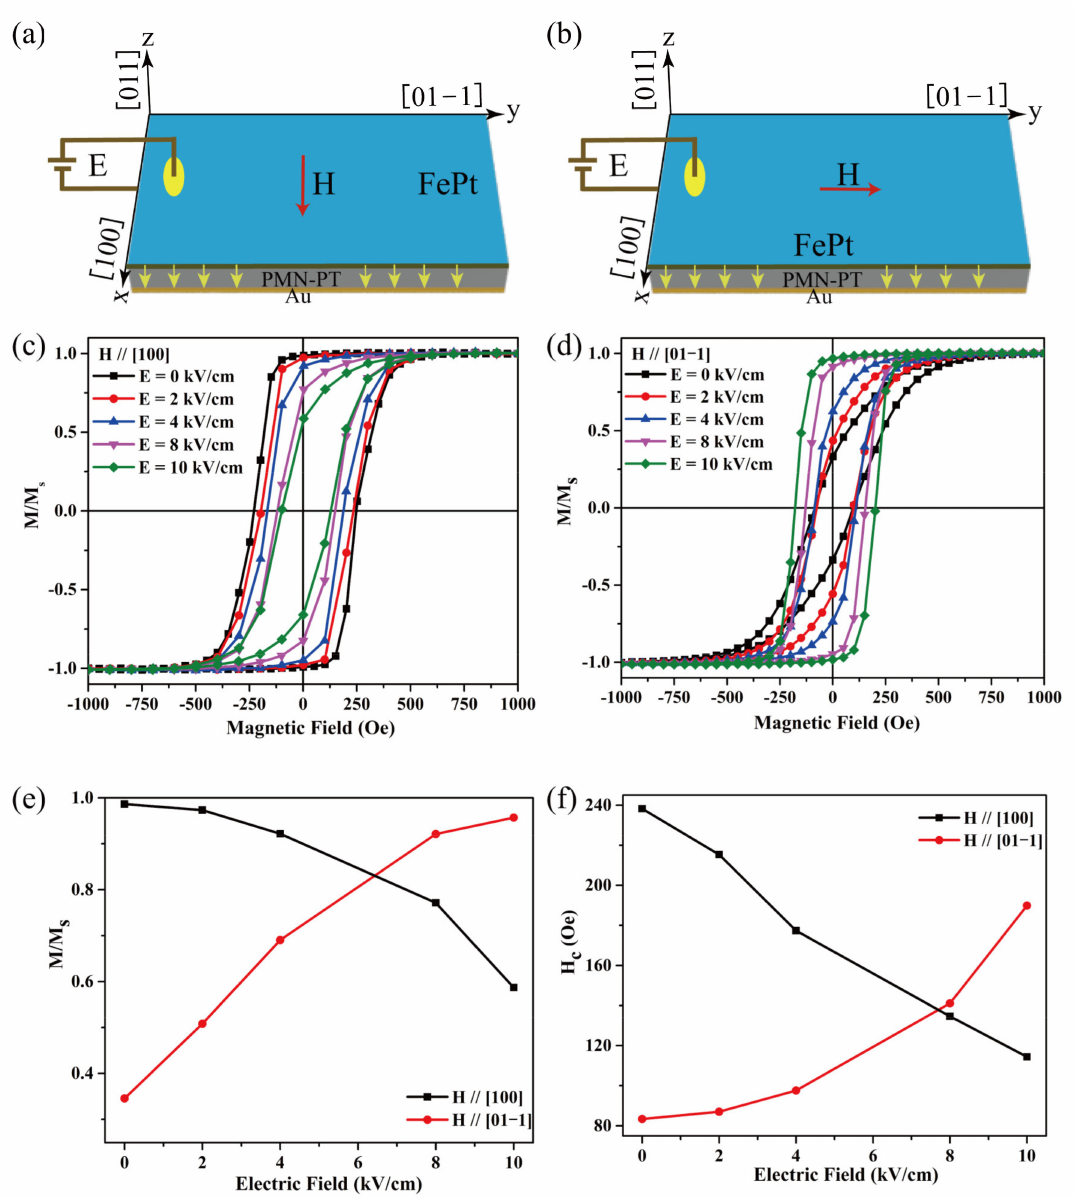
Figure 2. Schematic images for M–H loops measured under electric fields along the [100] direction ( a ) and [01 − 1] directions ( b ), respectively; the M–H loops measured under different electric fields along the [100] ( c ) and [01 − 1] ( d ) directions, respectively; electric-field controlled Mr and Hc along the [100] ( e ) and [01 − 1] ( f ) directions,